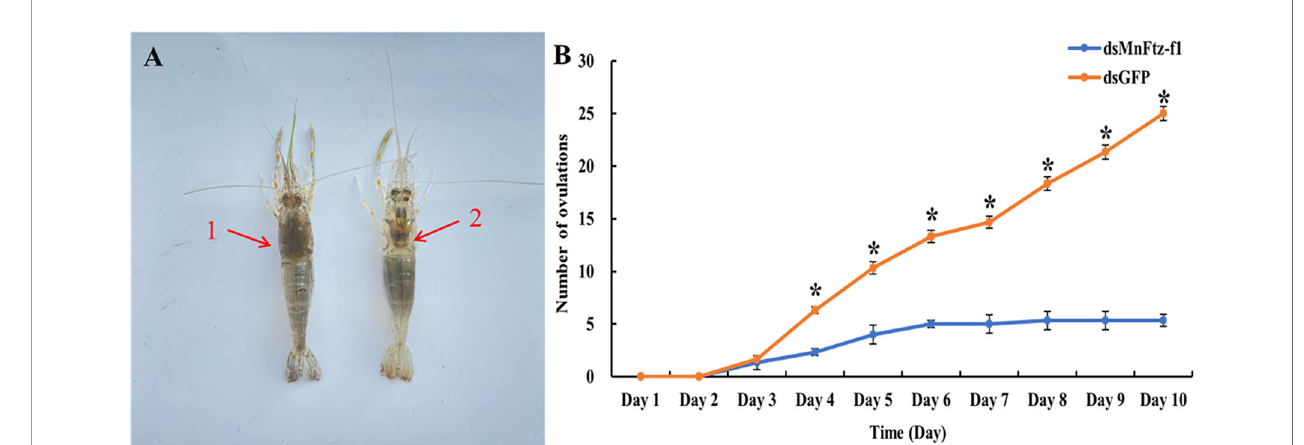
FIGURE 13 | The number of ovulations of M. nipponense in the experimental and control groups after RNAi (B) . GFP was used as a control. 1, non-ovulation, 2, ovulation (A) . Data are expressed as mean ± SEM, and the differences were considered to be signi fi cant at P < 0.05 ( * ) by Student ’ s t -test.